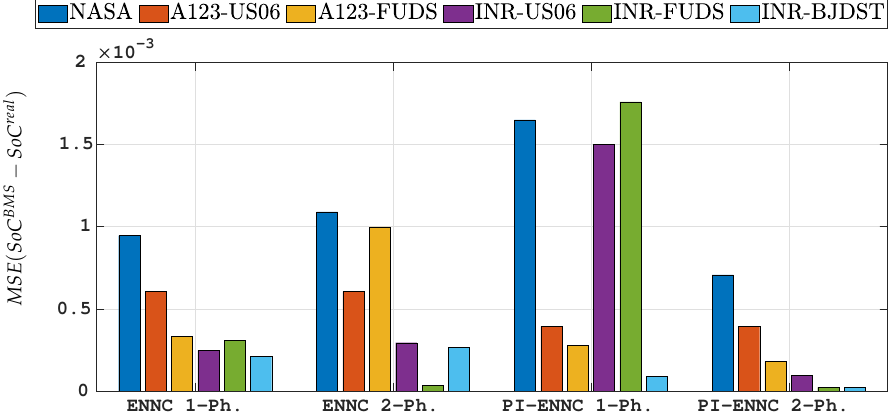
Figure 17. Best ENNC and PI-ENNC models performance on the test sets considering both training procedures, 1-Phase and 2-Phases .